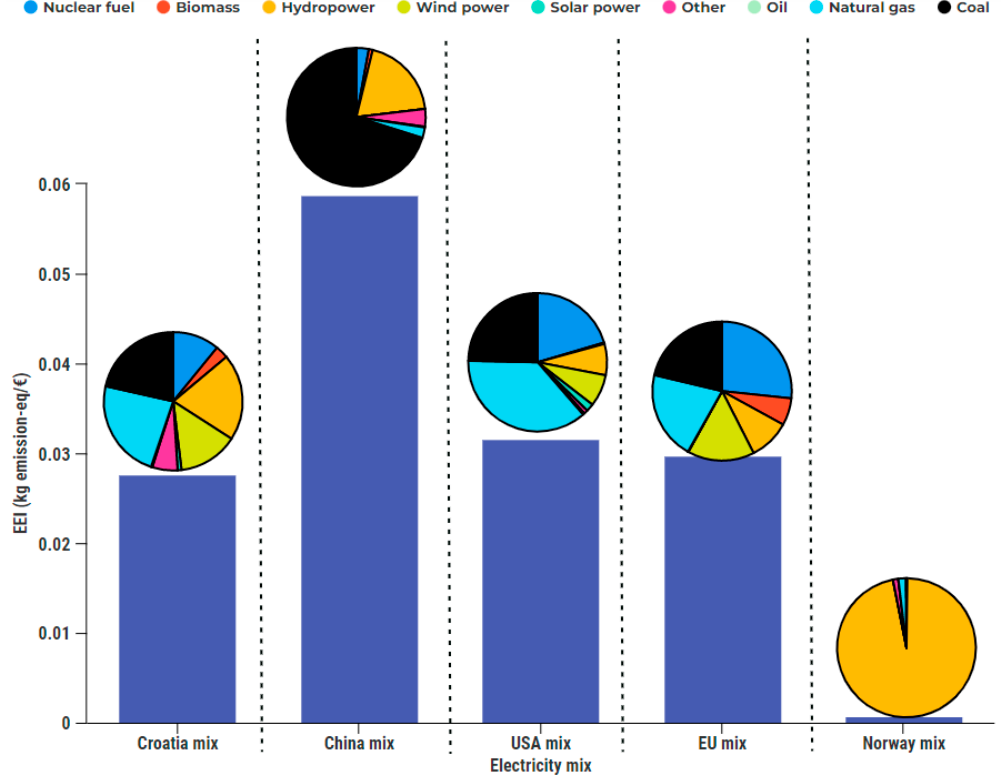
Figure 9. Impact of different electricity mixes on EEI .